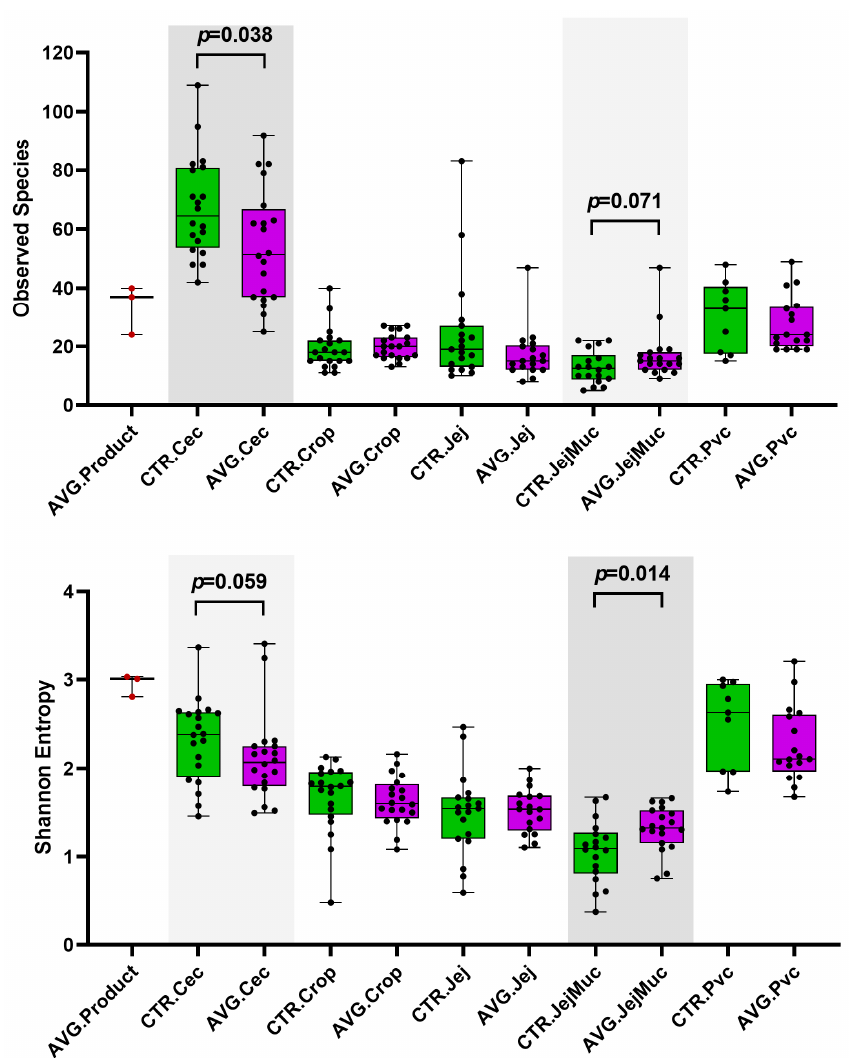
Figure 3. Alpha Diversity plots showing the Observed Species and Shannon Entropy. Cec = caecum, Jej = jejunum, Jej.Muc = jejunal mucosa, Pvc = proventriculus.